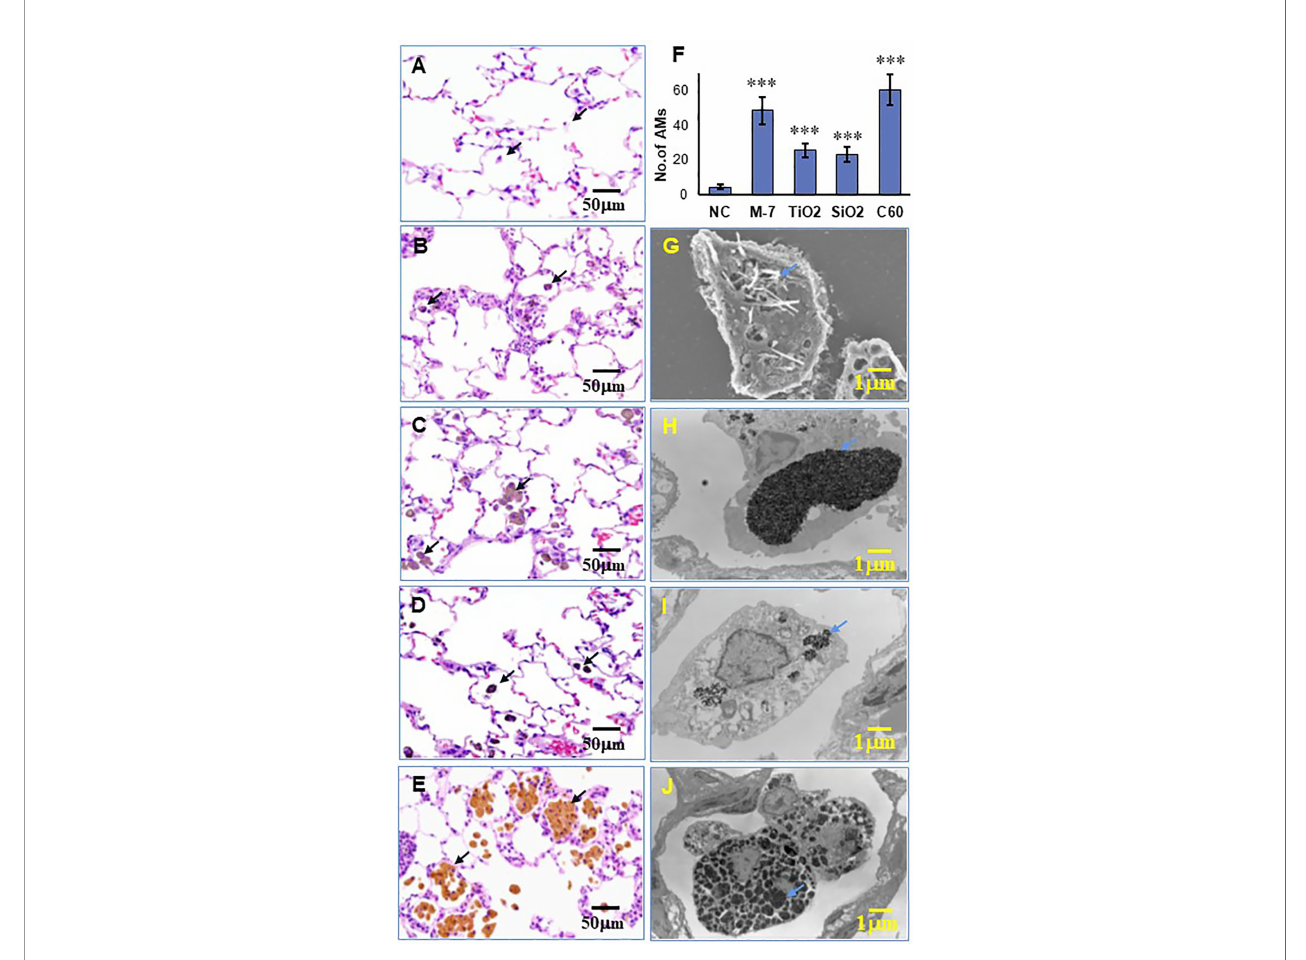
FIGURE 1 | Lung in fl ammation and phagocytosis of ENMs by alveolar macrophages. Female SD rats were intratracheally sprayed with 0.5 ml of 500 m g/ml MWCNT-7, TiO 2 , SiO 2 , or C60 suspensions. Lung in fl ammation in HE-stained slides was examined under light microscopy, and alveolar macrophages with phagocytosed ENMs were indicated with black arrows in the left panel. Representative HE images treated with the control, MWCNT-7, TiO2, SiO2, or C60 were shown in (A – E) , respectively. The number of alveolar macrophages per 200x sight fi eld in the treated lung tissues was presented in (F) . Phagocytosis of MWCNT-7 in (G) was observed under scanning electron microscopy, while the phagocytosed TiO2, SiO2, or C60 in (H – J) , respectively, were observed under transmission electron microscopy. The blue arrows in the right panel indicated the phagocytosed ENMs, and *** represents p values less than